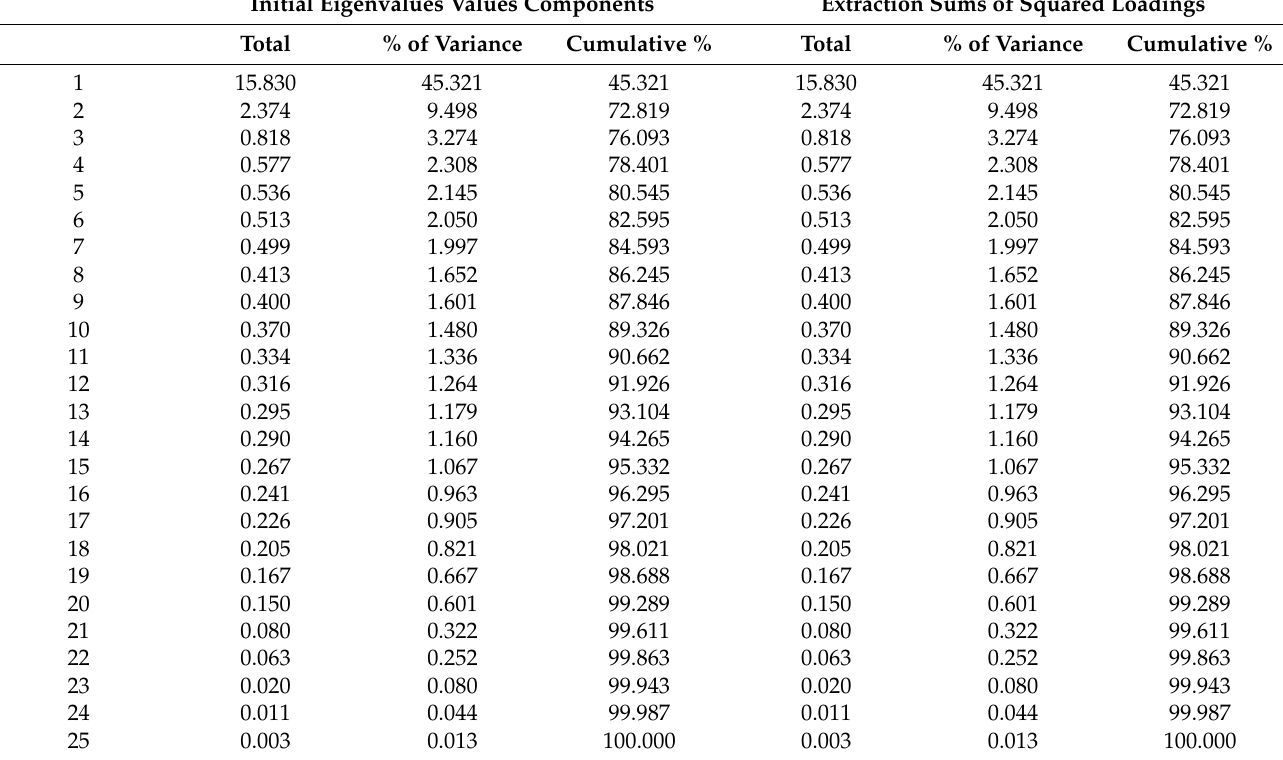
Table 2. Common Method Bias